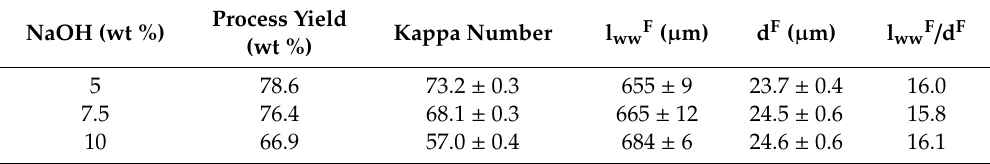
Table 1. Process yield, Kappa number and morphology of hemp core fibers treated at di ff erent NaOH concentrations. Process Yield NaOH (wt %) (wt